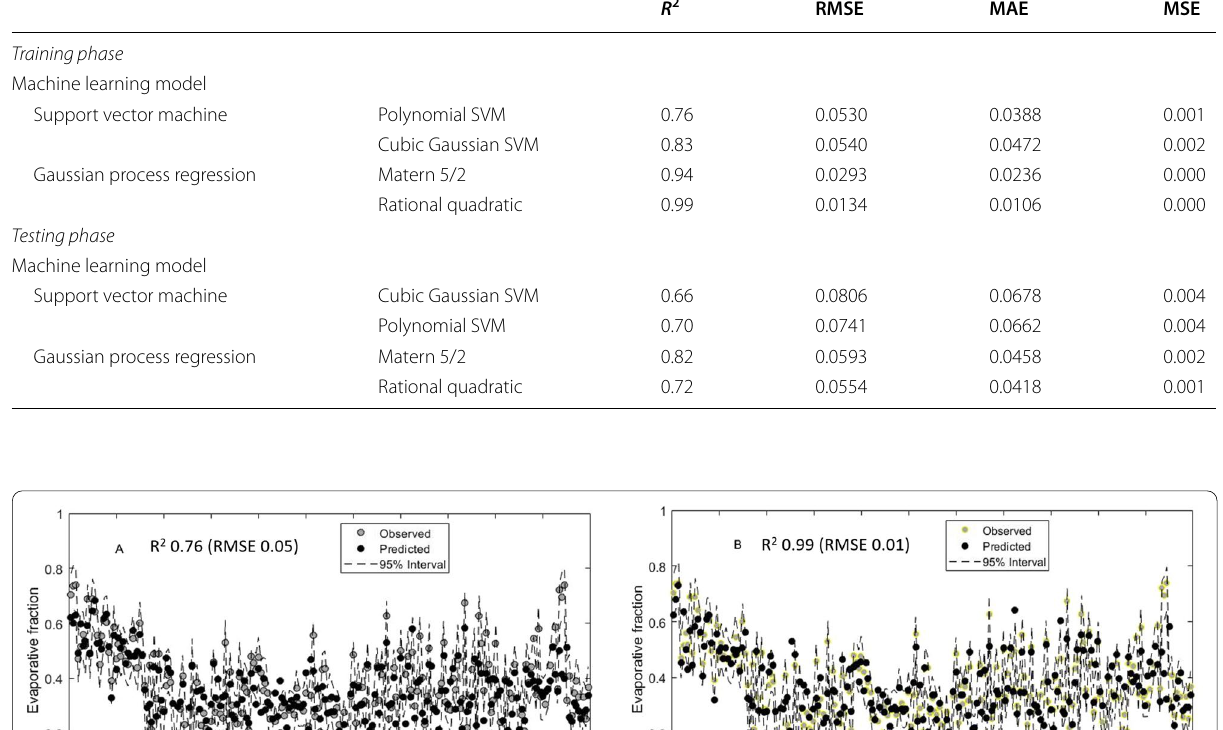
Table 4 Results of the evaluation criteria applied on the 4 ML algorithms selected during the training-and-testing phase R 2 RMSE MAE MSE